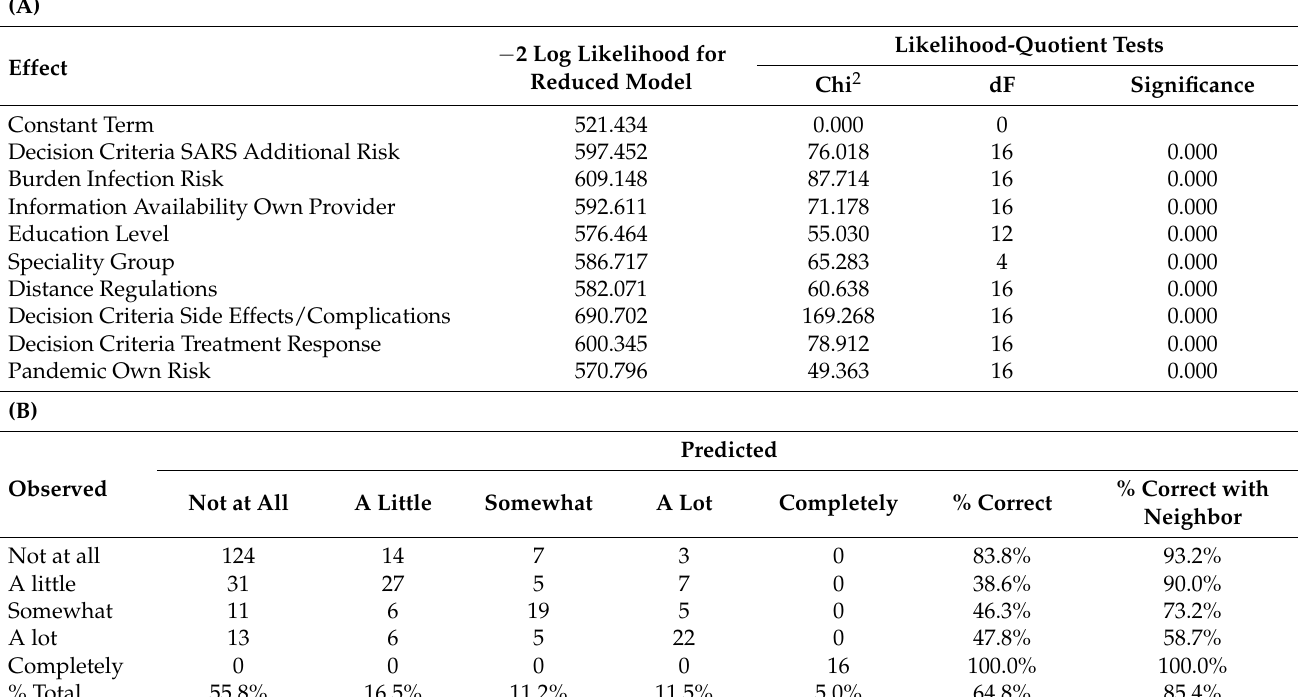
Table 1. Prediction by nominal regression analysis for “Decisional Uncertainty” (A) Likelihood- Quotient Test for regression parameters; and (B) resulting